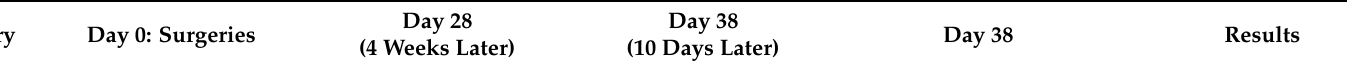
Table 5. Experimental design flow chart depicting animal grouping and sequence of the main procedures in the section, describing the effect of intensive trigeminal indirect stimulation, produced by its forced overuse due to excision of the contralateral infraorbital nerve (Ion) after transection and suture of the buccal branch of the facial nerve (Bn-n), on the accuracy of muscle